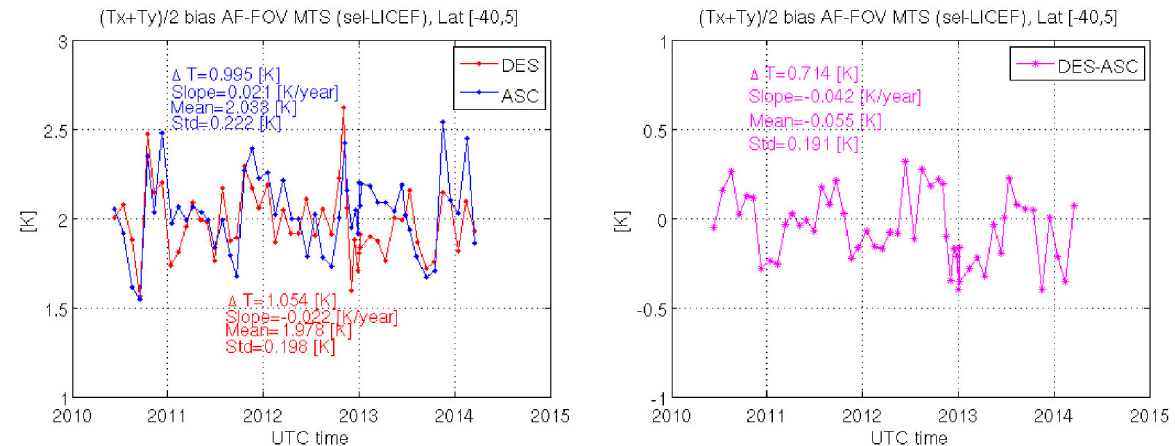
Fig. 4. – Assessment of brightness temperature long-term stability over ocean. Left, first Stokes TB mean bias (difference between the meas- urement and the model) in the AF-FOV (Alias-Free Field of View) for ascending/descending orbits. Right, difference between ascending and descending